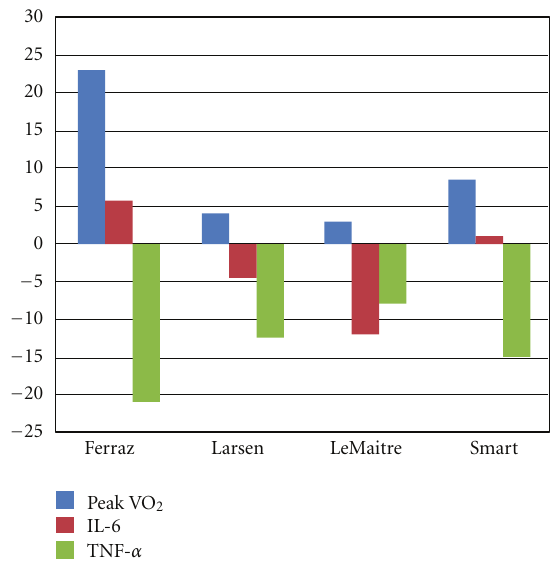
Figure 1: Change in cytokines and peak VO 2 across the four